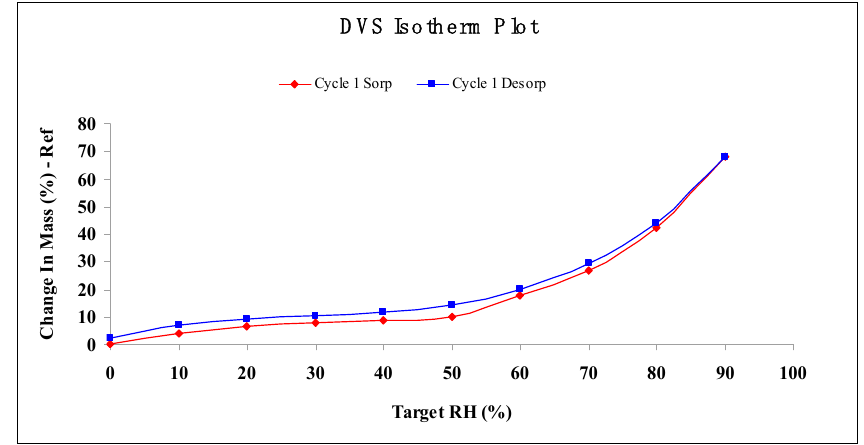
Figure 7. Water sorption/desorption properties of TPC-A. DVS: dynamic vapor sorption; RH: relative humidity.